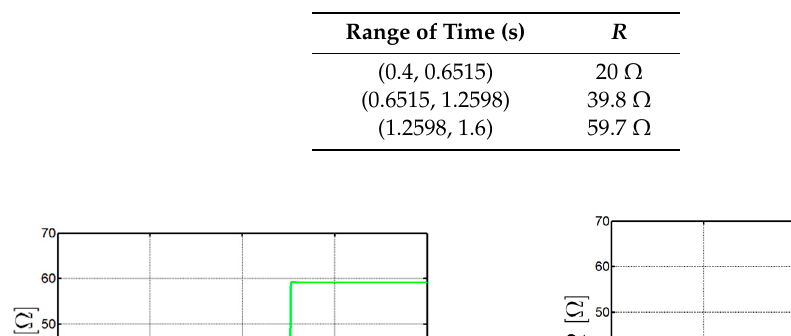
Table 6. Changes in the load R .